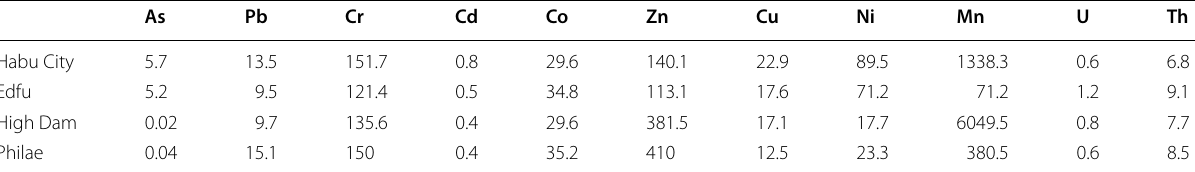
Table 3 The concentration of the elements in soils for the studied localities (ppm) As